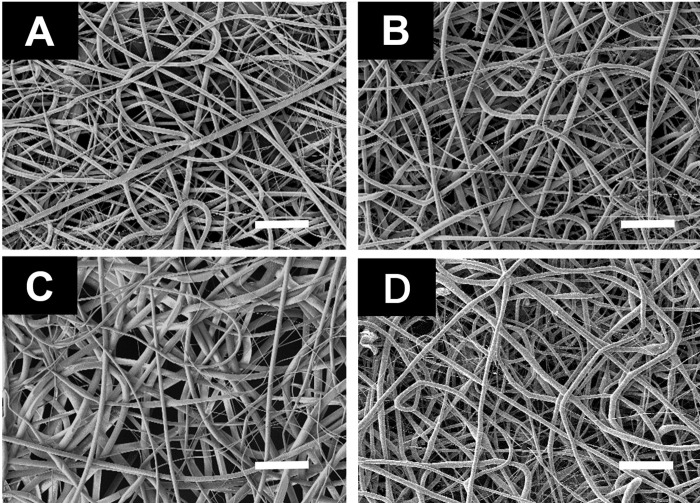
Scanning electron microscope (SEM) photo.The scanning electron microscope (SEM) photo of the PLGA fiber substrates. (A) PLGA, (B) PLGA/PDGF-BB, (C) pDA/PLGA (D) pDA/PLGA/PDGF-BB. bar = 10 μm.